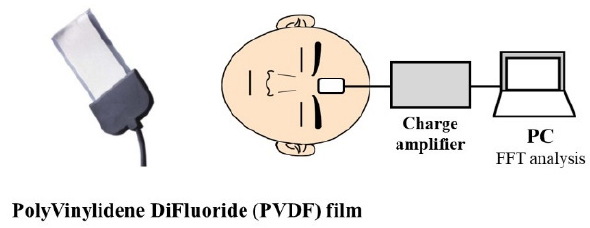
Figure 9. The setup for measuring skull vibrations using PolyVinylidene DiFluoride film.